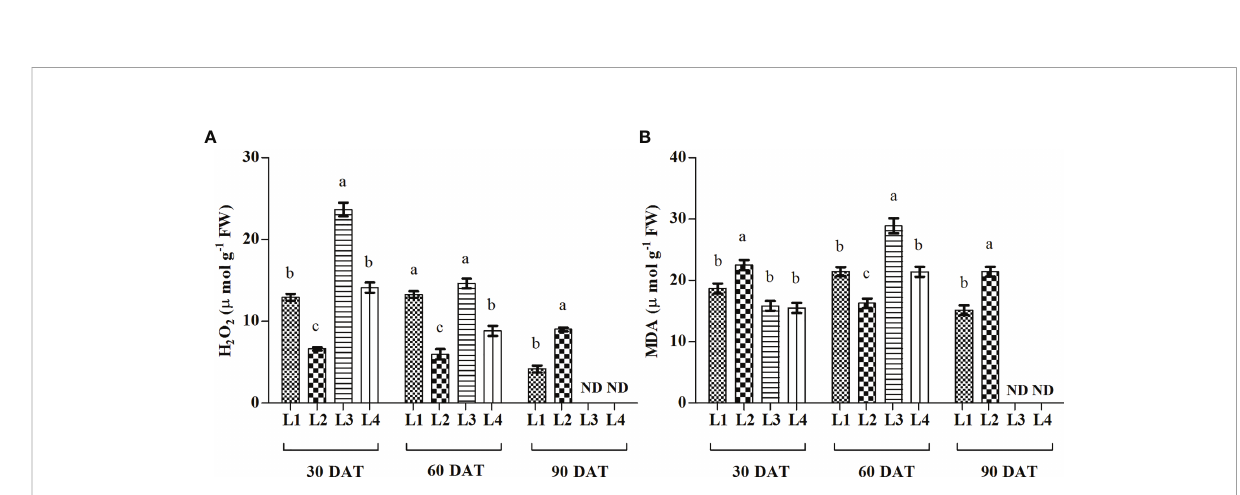
FIGURE 5 Effect of LED spectra on hydrogen peroxide ( A , H 2 O 2 ) and malondialdehyde ( B , MDA) of hemp seedlings at 30, 60, and 90 DAT. Here and subsequent fi gures: L1, MW 240 (Red 35% + Blue 25% + Green 40%); L2, FS 240-UV (Red 40% + UVA and Blue 26% + Green 29% + Far red 5%); L3, MB 240 (Red 85% + Blue 15%); L4, PF 240 (Red 70% + Blue 30%); ND, not detected. All treatments used a photosynthetic photon fl ux density of 300 µmol m − 2 s − 1 . Column height indicates the mean, vertical bars indicate the standard error of the mean (n = 4), and different letters indicate signi fi cant differences at p <